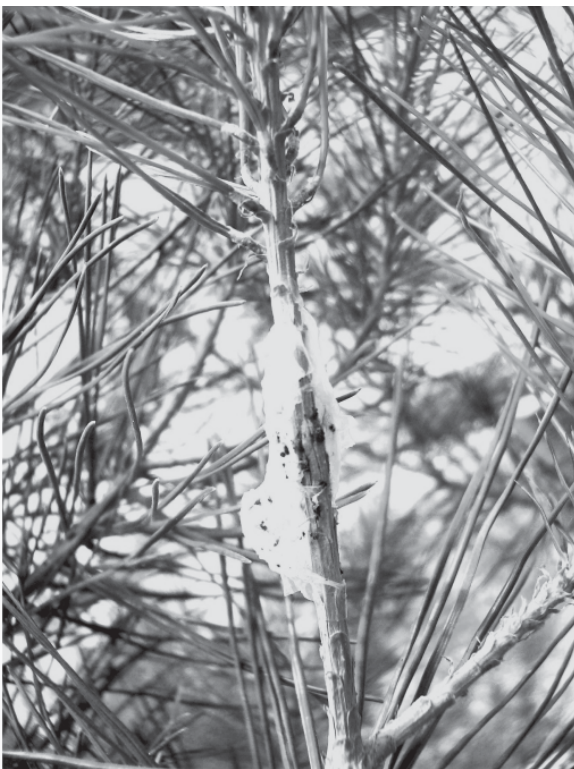
Fig. 1. Symptoms on Pinus halepensis inoculated with Diplodia pinea . Note the asexual fruiting structures (pycnidia) surrounding the wound on the infected branch.